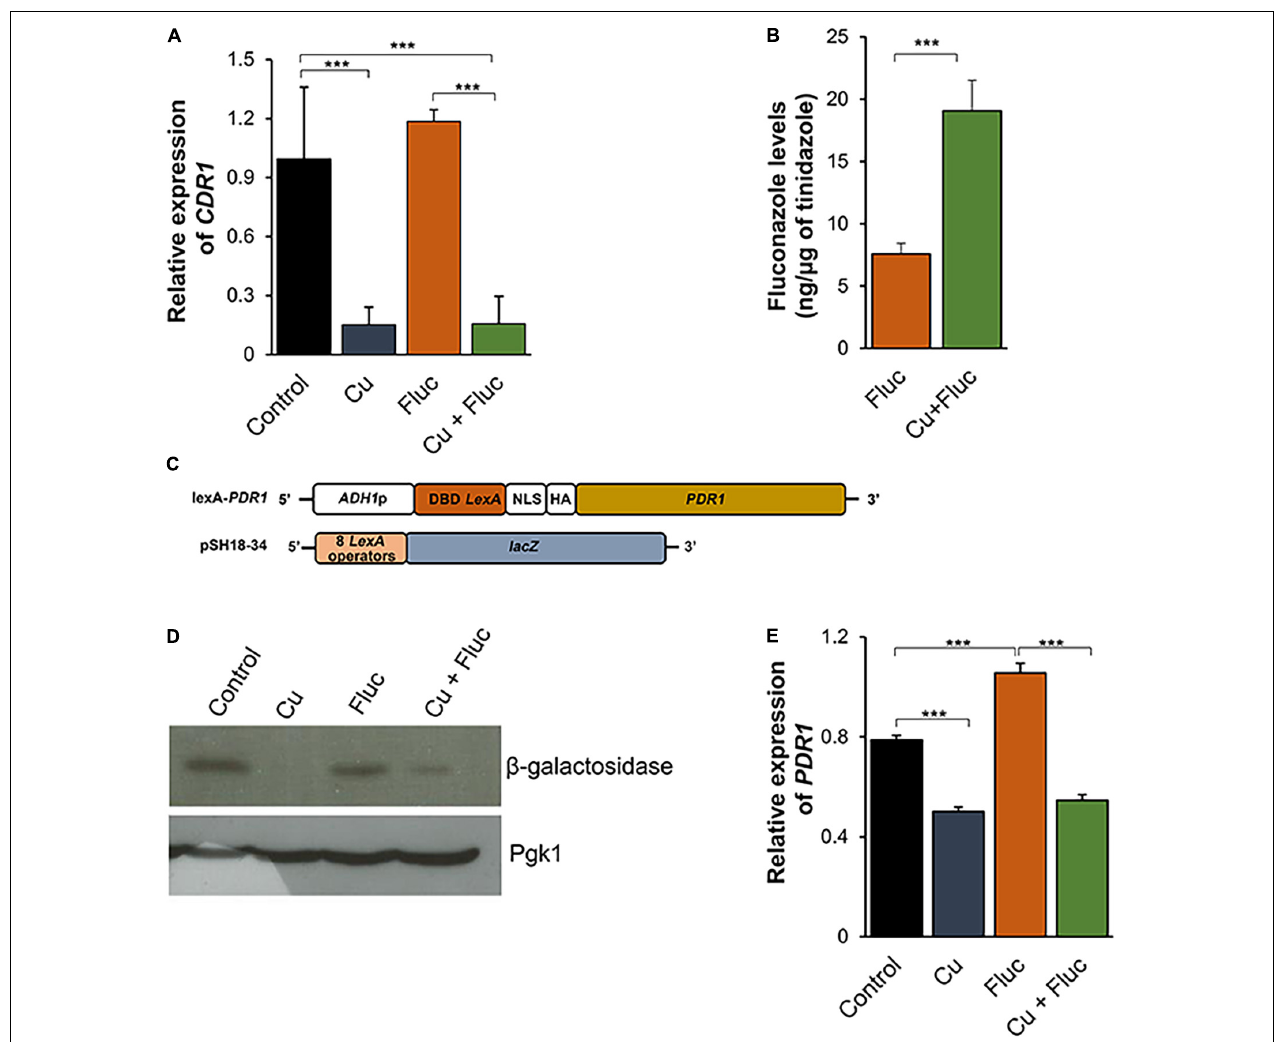
FIGURE 5 | Copper treatment inhibits Pdr1 activity, downregulates CDR1 expression and impairs fluconazole detoxification. (A) The expression of the CDR1 gene in cells untreated (Control) or treated with 1.25 mM CuSO 4 (Cu), 32 µ g/mL fluconazole (Fluc), or both (Cu + Fluc), was analyzed by qRT-PCR. (B) The accumulation of fluconazole in cells untreated (Control) or treated with 625 µ M of CuSO 4 (Cu), 32 µ g/mL fluconazole (Fluc), or both (Cu + Fluc) was measured by HPLC. The amount of fluconazole was normalized relatively to tinidazole (internal standard). (C) Scheme depicting the constructs used in the transactivation assay (D) . (D) S. cerevisiae EGY48 strain transformed with LexA-PDR1 and pSH18-34 was grown until mid-log phase in selective media and treated (or left untreated) with 625 µ M CuSO 4 (Cu), 64 µ g/mL fluconazole (Fluc), or both (Cu + Fluc) for 2 h. β -Galactosidase protein levels were analyzed by Western blot. Pgk1 was used as loading control. (E) The expression of the PDR1 gene was assessed by qRT-PCR. Significance of differences was calculated using Student’s T -test (*** p -value <